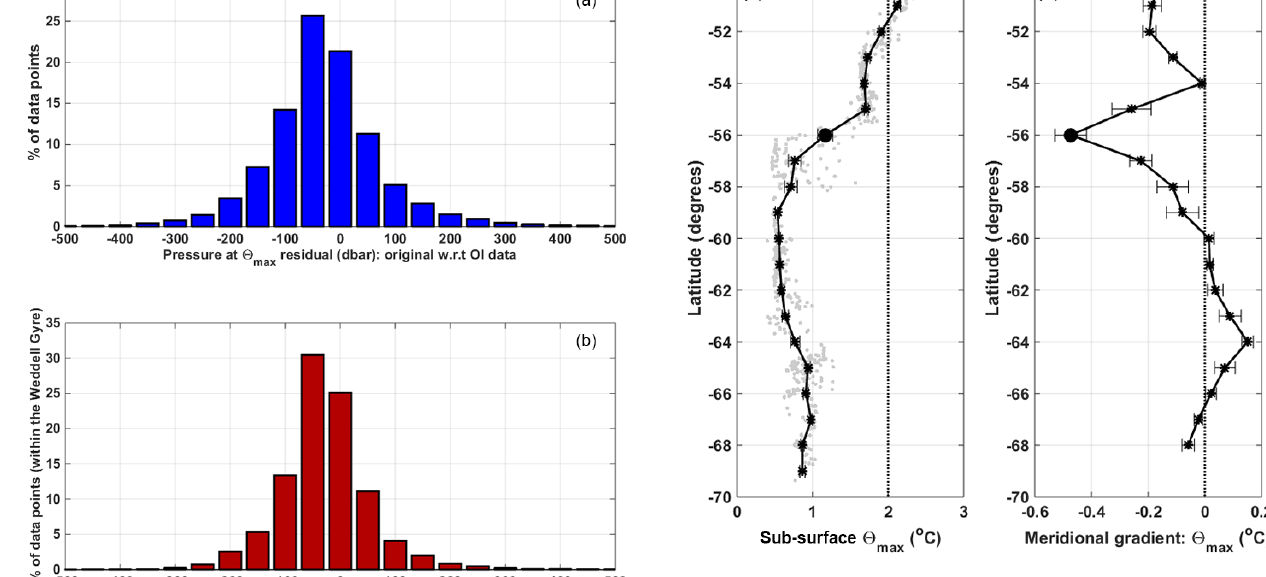
Figure 20. Panel (a) : mean meridional temperature distribution ( ◦ C) at the sub-surface temperature maximum extracted from the mapped field in Fig. 11b for longitude bins encompassing the Prime Meridian. The meridional gradient of the temperature maximum is shown in panel (b) . The large, solid, circular symbols mark where the magnitude of the gradient is largest – this marks the latitude of the northern boundary of the gyre for this longitude. The error bars both in panel (a) and (b) represent the propagation of the mapped errors from each grid cell used in the calculation (i.e. two grid cells, immediately to the east and west of the Prime Meridian). The orig- inal profiles within 1 ◦ of the Prime Meridian are shown in grey in panel (a)